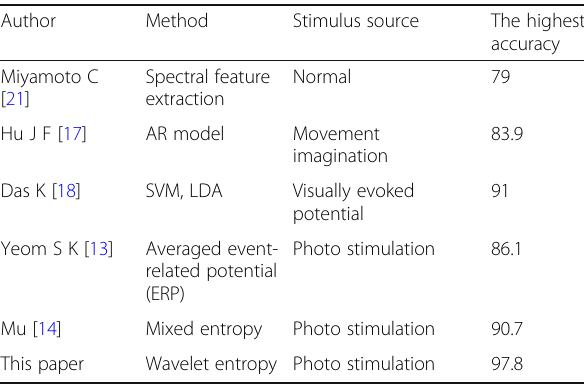
Table 3 Comparison of existing representative